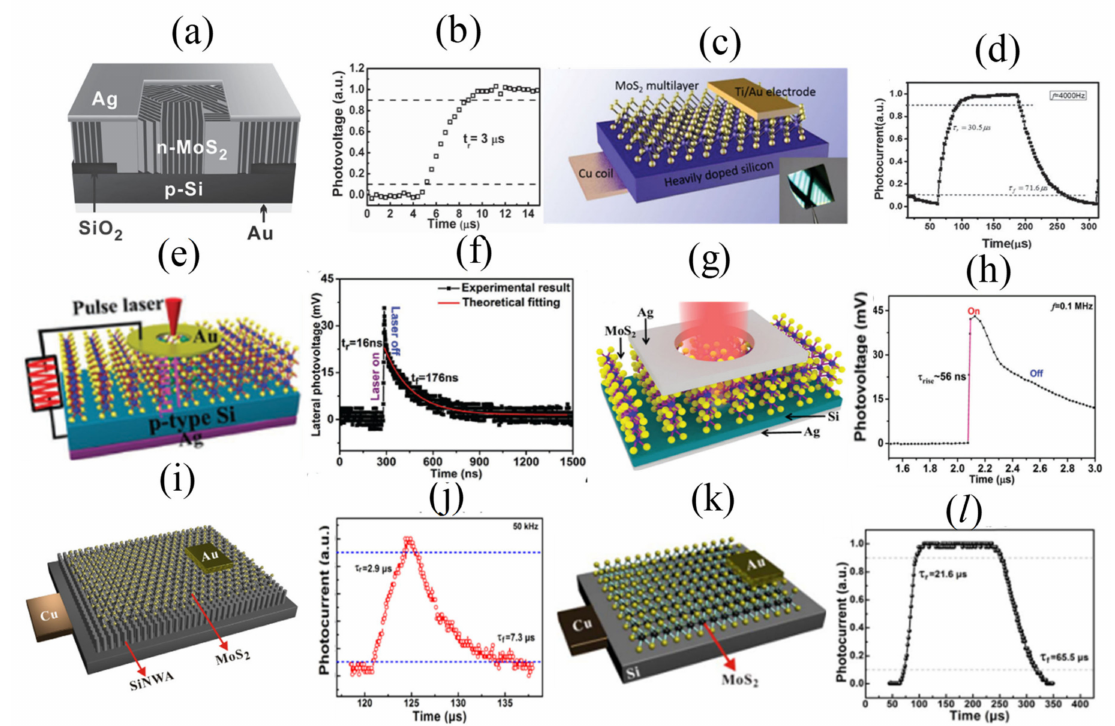
Figure 13. ( a , b ) Schematic illustration of the MoS 2 / Si hetero-junction-based photodetector, enlarged rise edge of the photoresponse curve. Reproduced with permission from reference [178]. ( c , d ) Schematic representation of the vertical multilayered MoS 2 / Si hetero-junction, magnified and normalized plots of one response cycle. Reproduced with permission from reference [179]. ( e , f ) Schematic of V-MoS 2 / Si hetero-junction, time-dependent lateral photovoltage for one pulse illumination (pulse width of 100 fs), Reproduced with permission from reference [180]. ( g , h ) Schematic illustration of the photoresponse of the V-MoS 2 / Si hetero-junction device, Time-dependent photovoltage at frequencies of 0.1 MHz (100 fs-pulse-width pulsed laser), Reproduced with permission from reference [181]. ( i , j ) Schematic diagram of a MoS 2 / Si NWA hetero-junction device fabrication. Rising and falling edges for estimating rise time ( τ r ) and the fall time ( τ f ) at 50 kHz, Reproduced with permission from reference [183]. ( k , l ) Schematic illustration of a MoS 2 / Si hetero-junction device, Rising and falling edges for estimating the rise time ( τ r ) and the fall time ( τ f ). Reproduced with permission from reference [184]. Table 3. Wavelength range, responsivity, response / recovery speed of MoS 2 on p / n doped Si substrate. Device